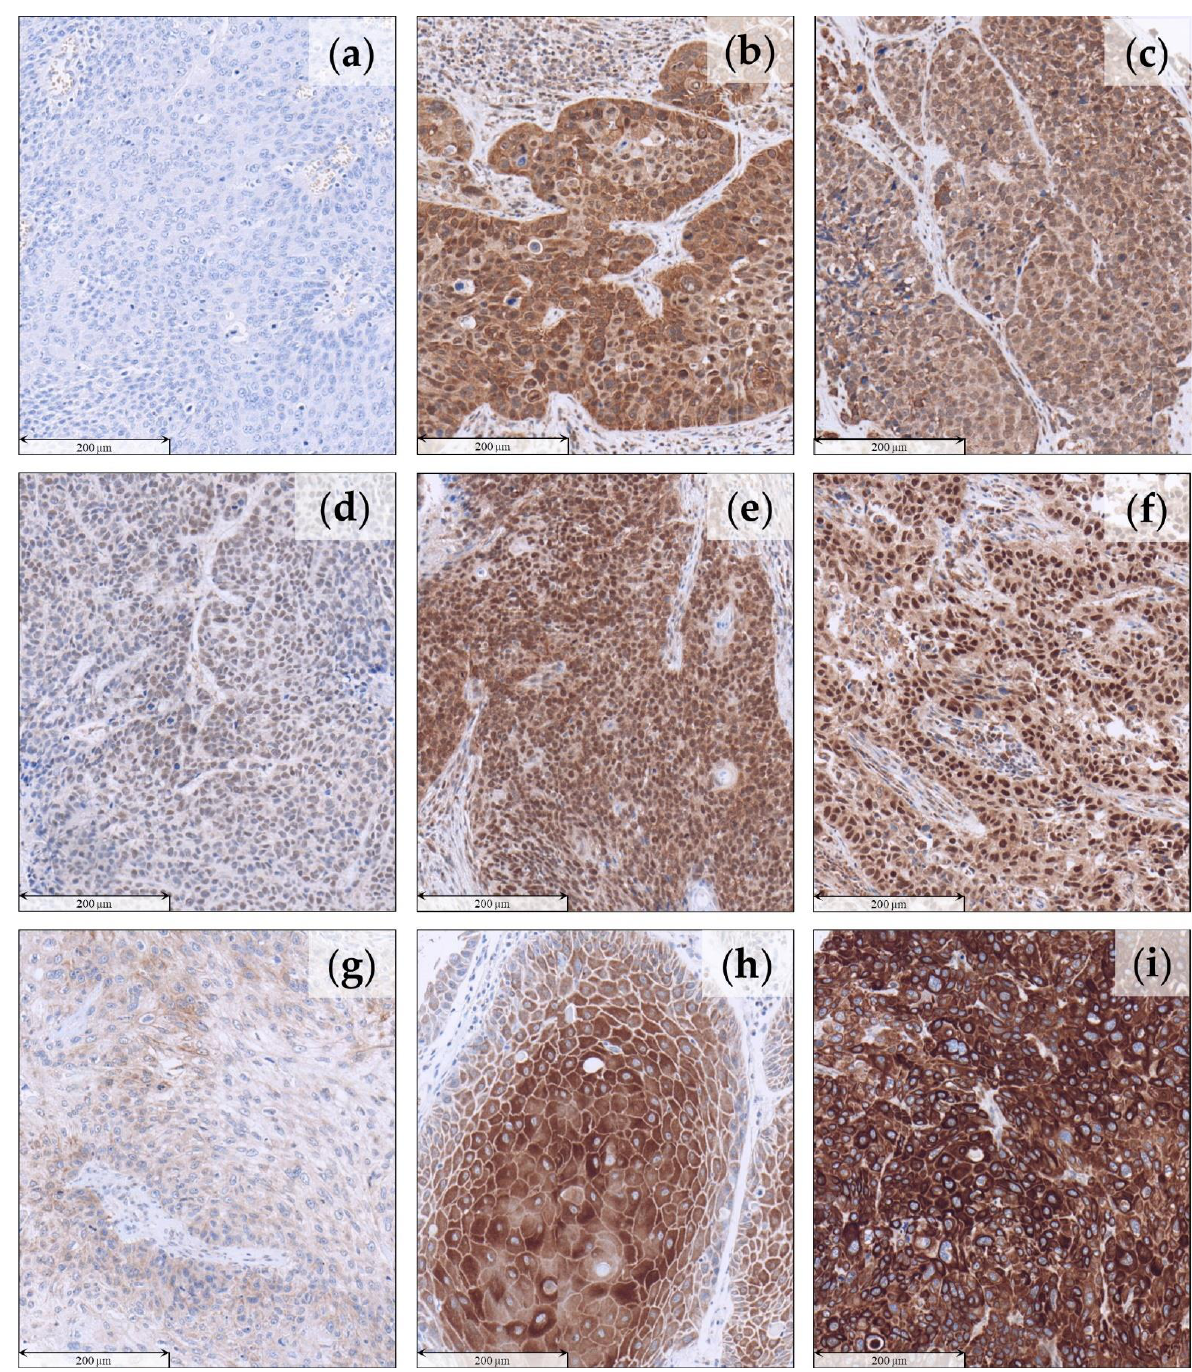
Figure 1. TRIM24 expression patterns in HNSCC tissue. ( a ) “Negative” HNSCC— no detectable TRIM24 expression within the tumor cells. ( b , c ) “Combined expression”— expression of TRIM24 in the tumor nuclei and in the tumor cytoplasm. ( d – f ) “Nuclear expression”— TRIM24 expression exclusively in the tumor nuclei. ( d ) Low nuclear expression. ( e ) Medium nuclear expression. ( f ) High nuclear expression. ( g – i ) “Cytoplasmatic expression”— TRIM24 expression exclusively in the cytoplasm. ( g ) Low cytoplasmatic expression. ( h ) Medium cytoplasmatic expression. ( i ) High cytoplasmatic expression.